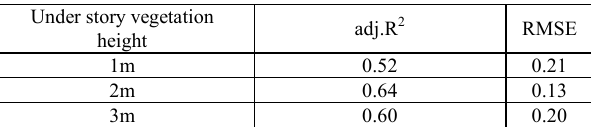
Table.2 Adj.R 2 and RMSE value of GLAS forest canopy